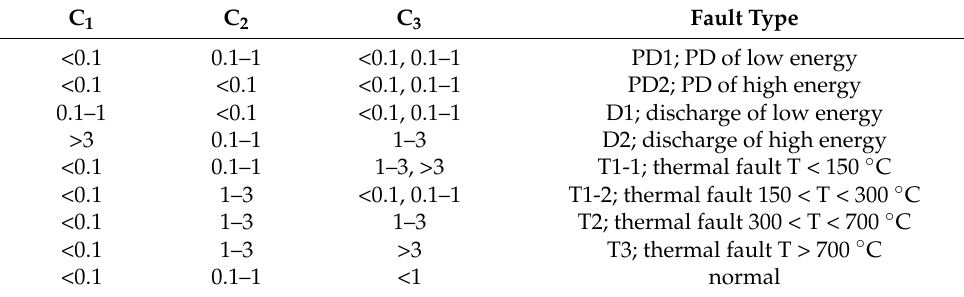
Table 3. Fault Identification Using IEC Ratio